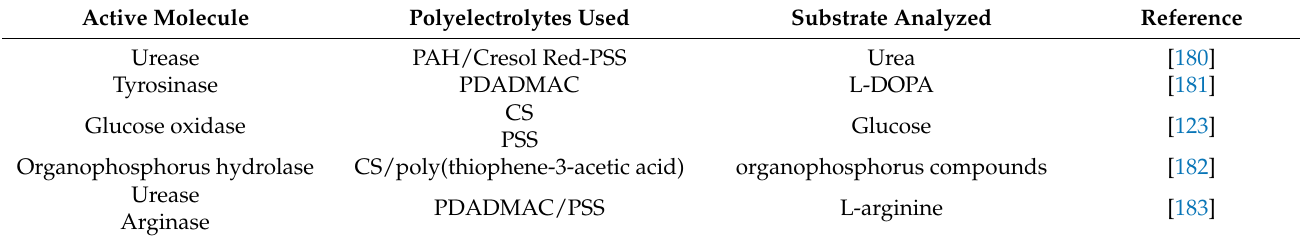
Table 4. Examples of optical biosensors based on the immobilization of enzymes into multilayers. Active